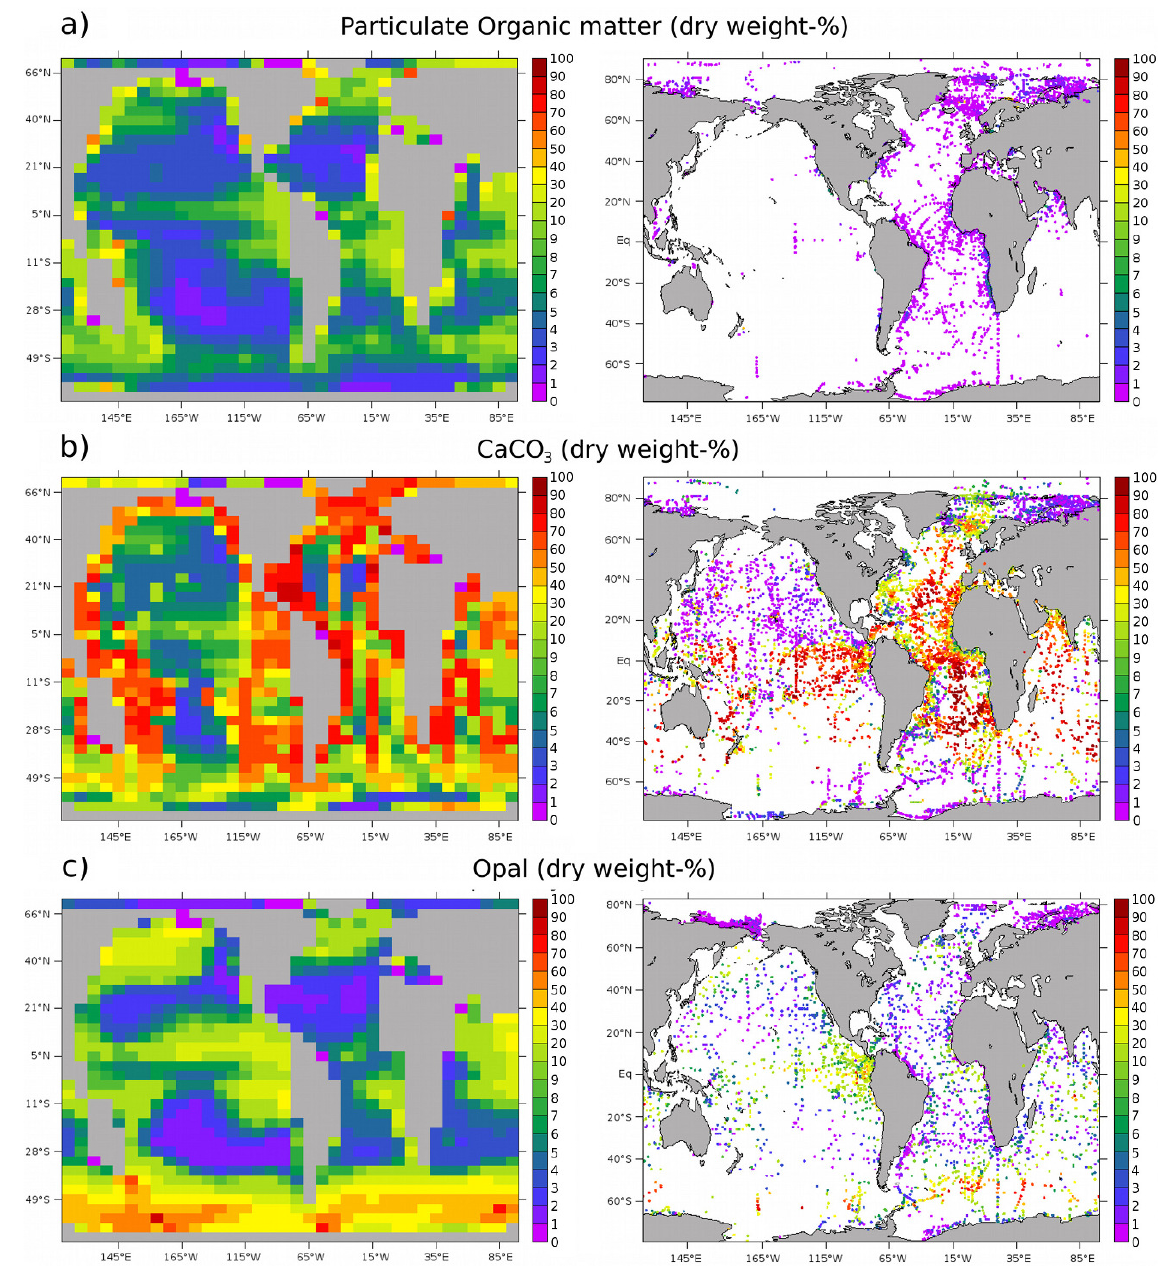
Fig. 1. Modelled (left row) and observed (right row) composition of surface sediments on the ocean bottom: (a) particulate organic matter, (b) CaCO 3 and (c) opal. Modelled sediment composition is averaged over the top 1.1cm of the sediment column. Sediment data is from the Pangaea database (publishing Network for Geoscientific&Environmental Data, http://orfois.pangaea.de). Note that the color scale is not